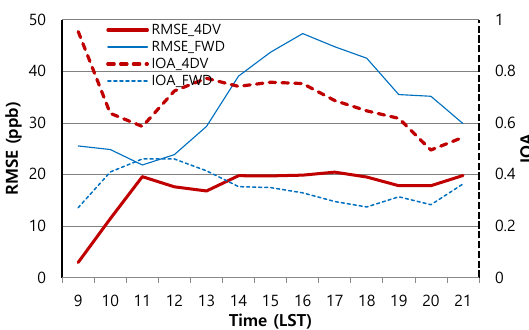
Figure 15. Diurnal variations of statistical results of IOA (dashed) and RMSE (solid) during the assimilation time window. The results with assimilation (4DV) are indicated by red and thick lines, and those without assimilation (FWD) are the blue and thin